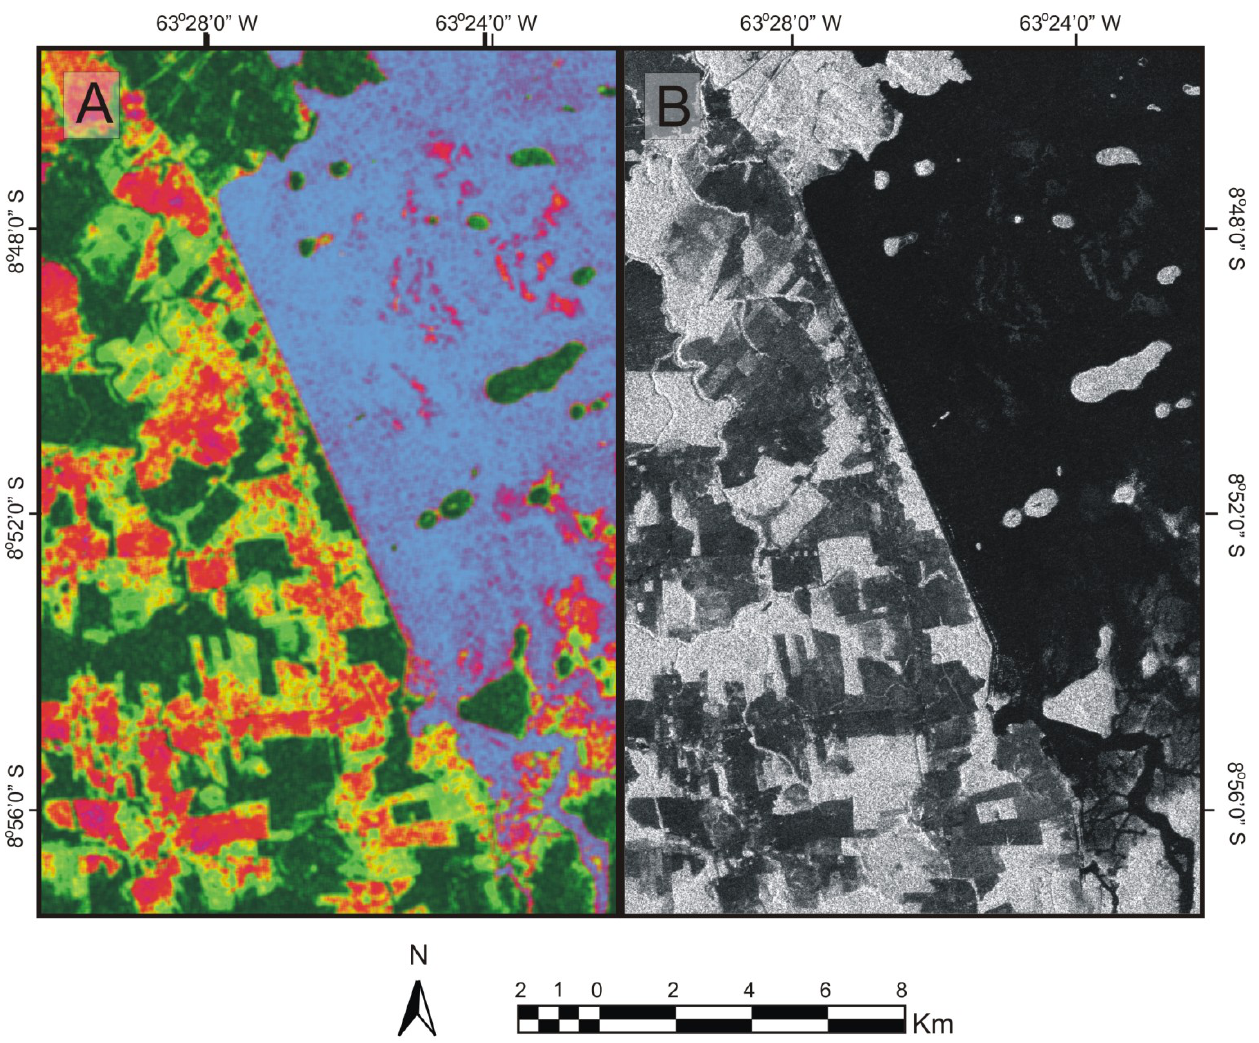
Figure 8. ( A ) RGB Color Composite: 2PDC-NAPC (red), 3PDC-NAPC (green)